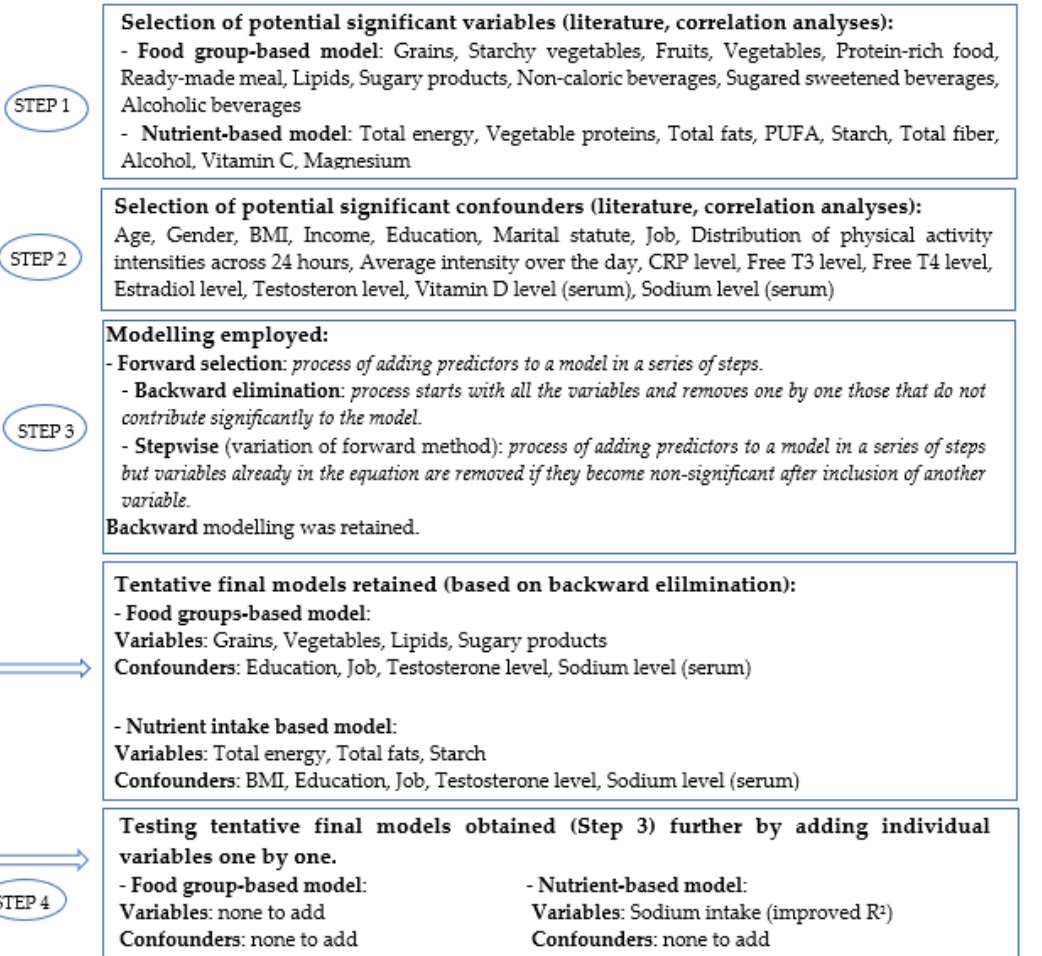
Figure 2. Linear regression progression (backward elimination). For the food group-based model, all food groups were kept in the original model. Nutrients and confounders were pre-selected based on the literature and on bivariate correlation analysis. Variables and confounders were eliminated stepwise in order to keep only significant variables or those where a trend was apparent ( p < 0.1).